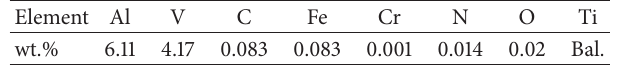
Table 1: Chemical composition of titanium alloy Ti6Al4V.